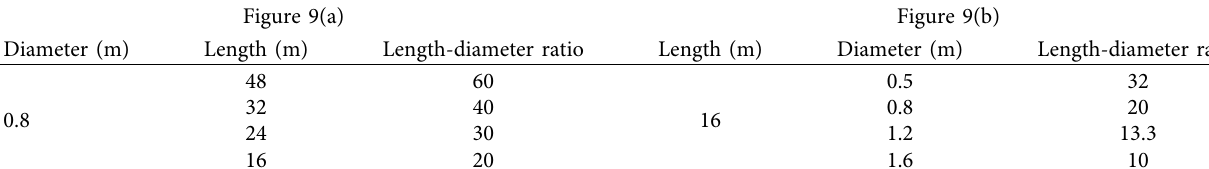
Table 1: Table of the calculation parameters for Figures 9(a) and 9(b).